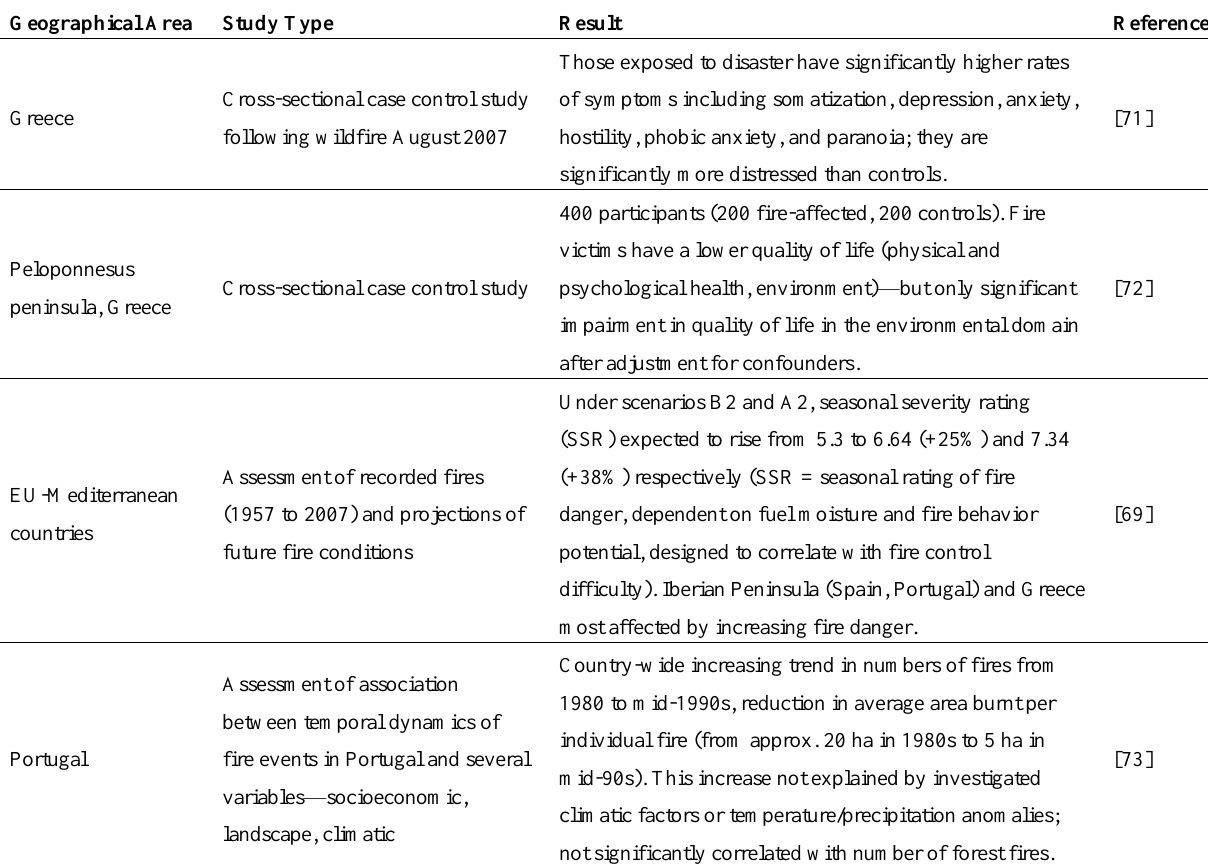
Table 5. Search results of literature about health effects from wildfires